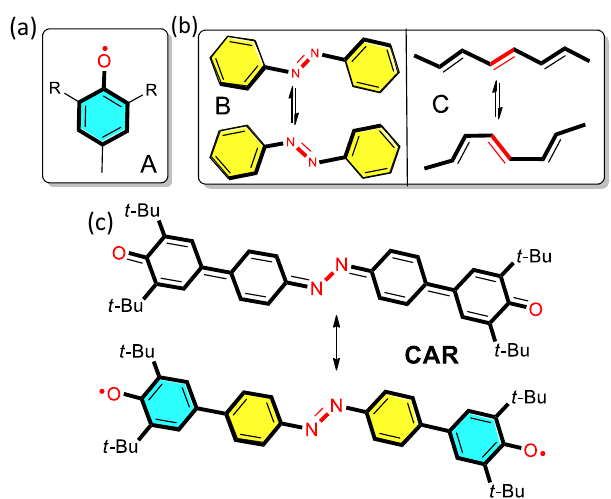
Fig. 1 Phenoxyl and azobenzene building blocks of CAR and the bicycle pedal motion. Phenoxyl ( a ) and azobenzene ( b ) building blocks of CAR with the bicycle pedal motion in azobenzene and in oligoenes. c Extreme quinoidal/aromatic canonical forms of CAR (note the differences between these extreme forms and the quinoidal-like, aromatic-like, and pseudoquinoidal forms discussed below that always correspond to hybrids with sizeable weights of the two extreme